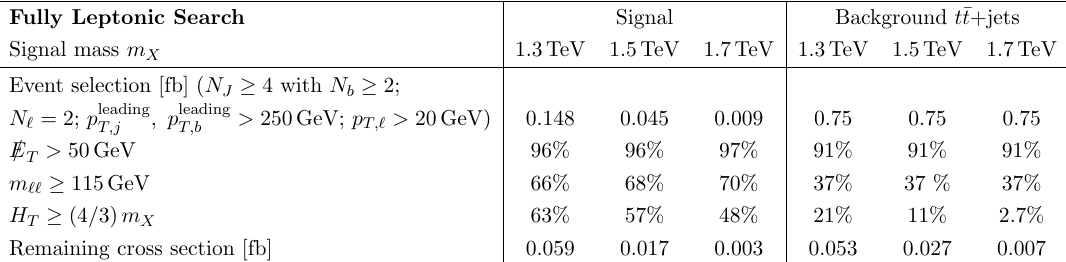
H T (cid:21) (4 = 3) m X